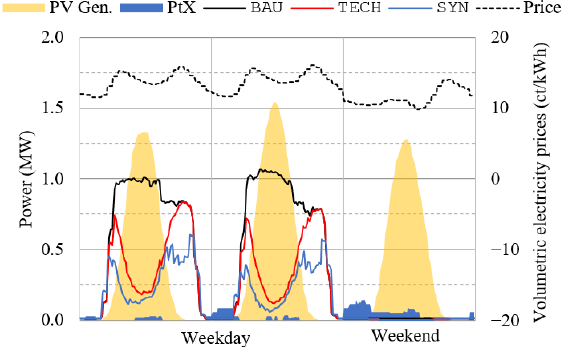
Figure 8. Average electricity import of the company, PV generation and electricity prices; PtX plots the import for the hydrogen production.